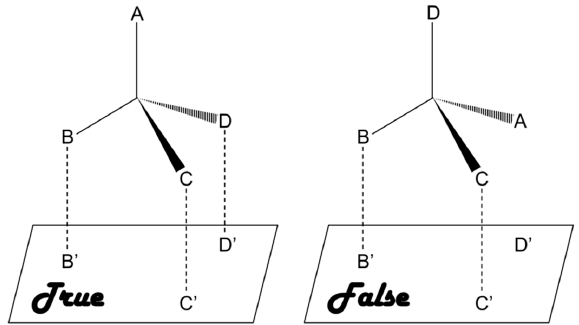
Figure 1. Three-point interaction model for describing the homochiral (true) and heterochiral (false) interactions.